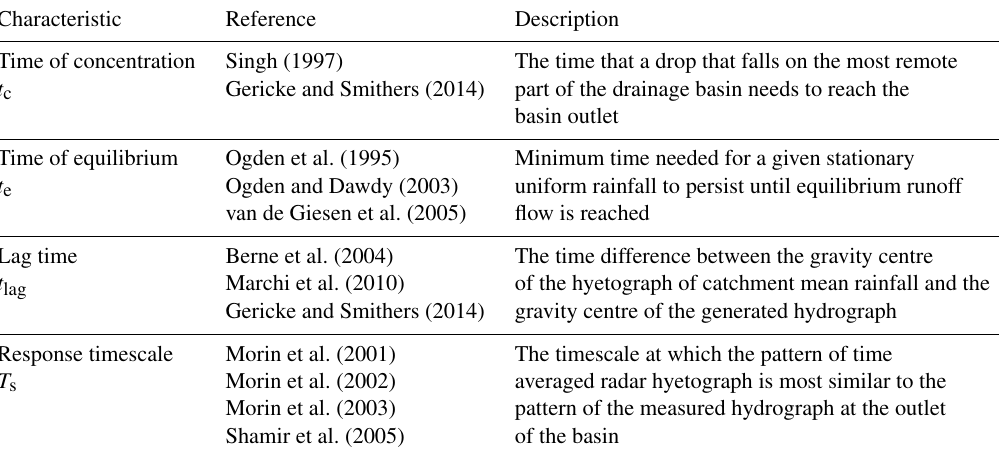
Table 1. Timescale parameters.